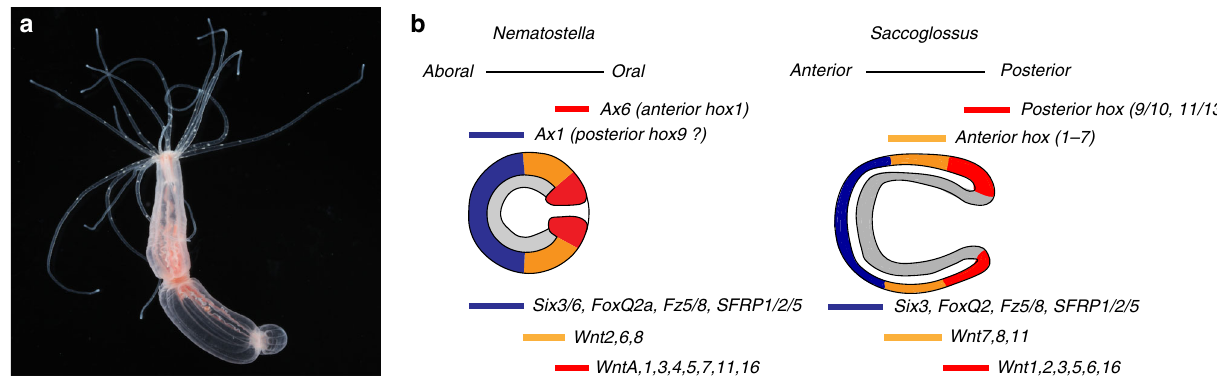
Fig. 1 Nematostella and the evolution of axial patterning systems. a A photograph of an adult Nematostella vectensis polyp. A ring of tentacles that are used for capturing prey surrounds the oral opening (oriented to the top). The “ oral ” opening serves as both mouth and anus and derives directly from the blastopore (to the right in b ). b Schematic drawing of gastrula stages of Nematostella vectensis and the hemichordate Saccoglossus kowalevskii , which serves as an example for a bilaterian embryo. The blastopore is oriented to the right. Relative gene expression domains are indicated to illustrate the support for different scenarios in the evolutionary relation of the primary body axis. Note that the gene expression domains are simpli fi ed and that some of the Nematostella Wnts are expressed in the endoderm. Data for Nematostella are summarized in refs. 5,12,13 , and for Saccoglossus in ref. 15 . Photo credit for a